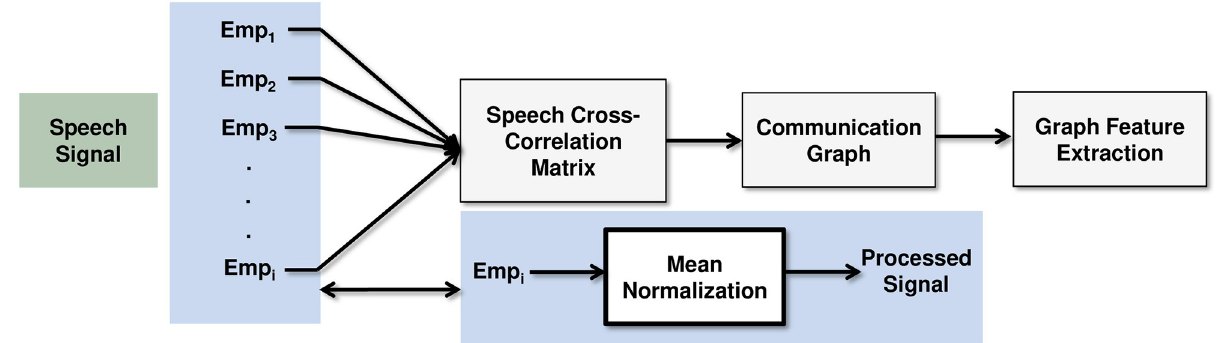
Fig 1. Process chain for communication graph